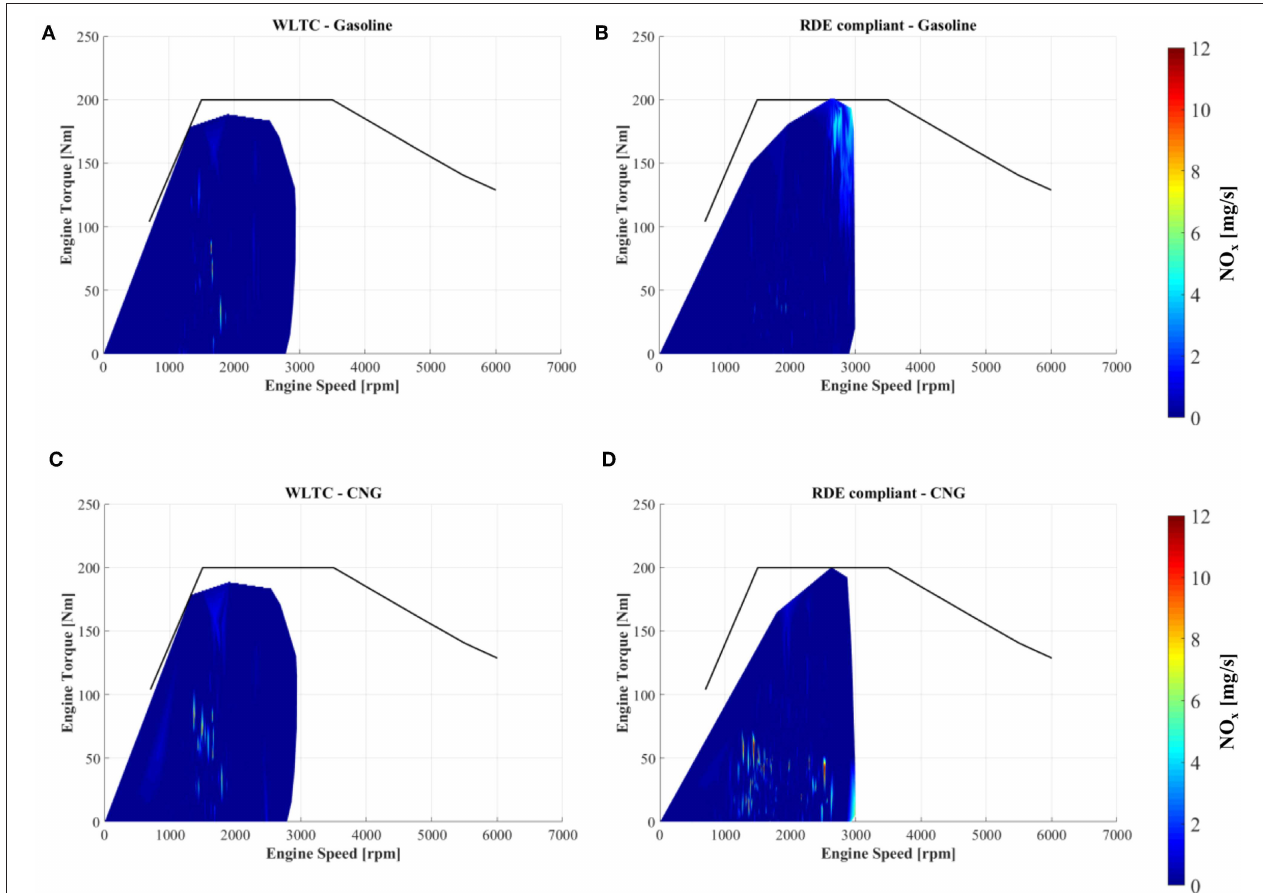
FIGURE 10 | Visualization of tailpipe NO x emissions of Vehicle 2 on the engine map. (A) WLTC and (B) RDE-compliant test with gasoline (C) WLTC and (D) RDE-compliant test with CNG.